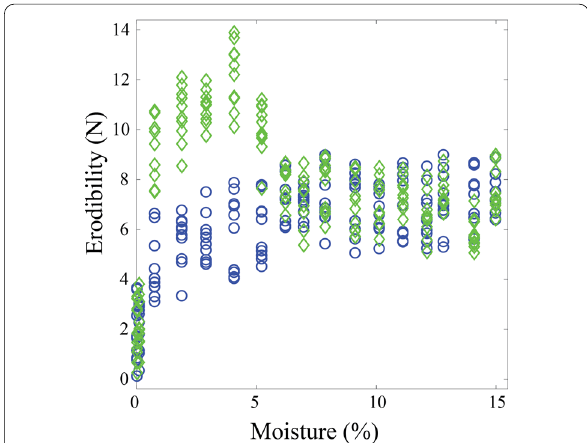
Fig. 4 Datasets corresponding to the given hypothesis (blue circles) and the alternative-unknown hypothesis (green diamonds). For each dataset, 220 measurements are plotted reflecting the maximum of 10 measurements at 22 locations. Participants only saw a subset of the complete dataset—data were randomly selected and presented from the larger distribution based on each participants’ strategy. See Additional file 1 for a more complete description of how each dataset was computationally generated